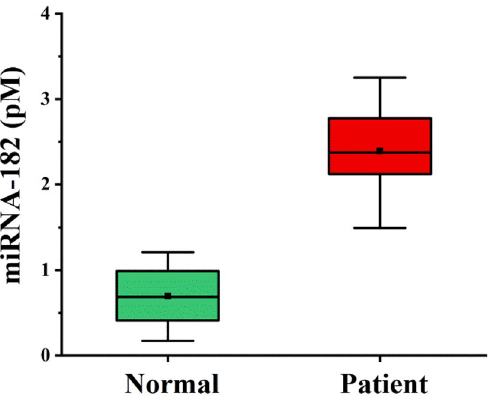
Figure 5. Concentrations of miRNA-182 from sera of three healthy donors and three glioma patients. Each sample was measured three times. The squares indicated the average levels of miRNA-182 from the